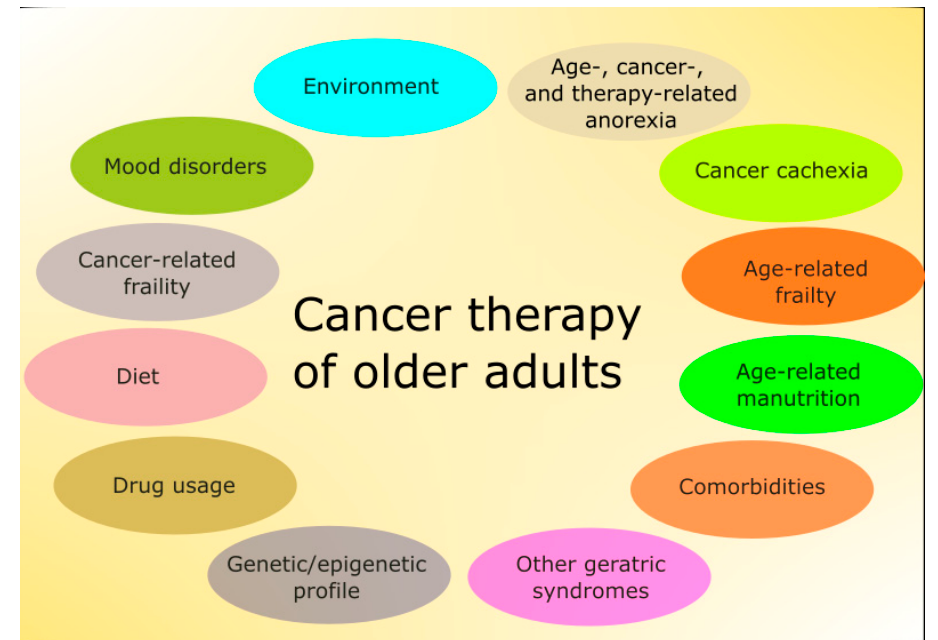
Figure 1. Main factors a ff ecting therapy in older adults with cancer. Some of these factors are mutually dependent and some partly overlap. Environment is understood here in a broad sense and also includes family and social relationships. Some factors, such as the diet, are of general significance, but have several features specific for this group of